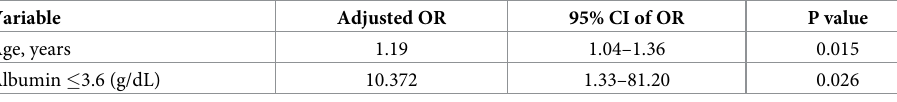
Table 3. Logistic regression analysis of predictors for on-treatment hepatic decompensation.